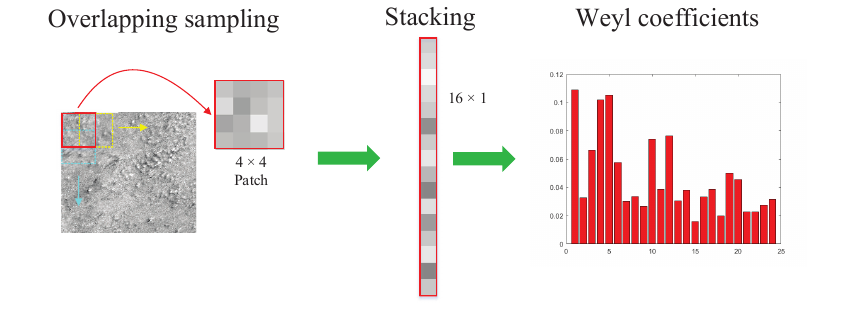
Figure 5. Computation of the Weyl coefficients for a Multibeam Echosounder System (MBES) backscatter image. The selected patch is vectorized by stacking its columns. The Weyl transform is applied to the stacked patch, and the dimensionality of the resulting coefficient vector is reduced by merging equivalent transformations to yield the Weyl feature